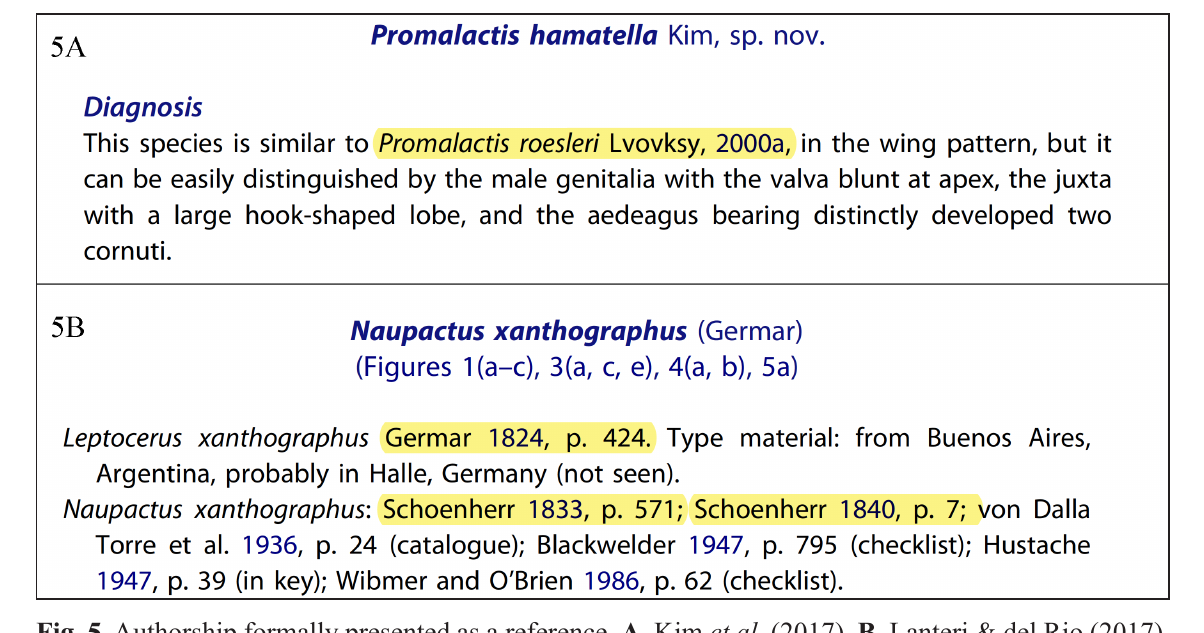
Fig. 4. The references highlighted in orange are not listed in the References section whereas the reference in yellow, because it is recent, is listed (Ardenghi et al. 2016).